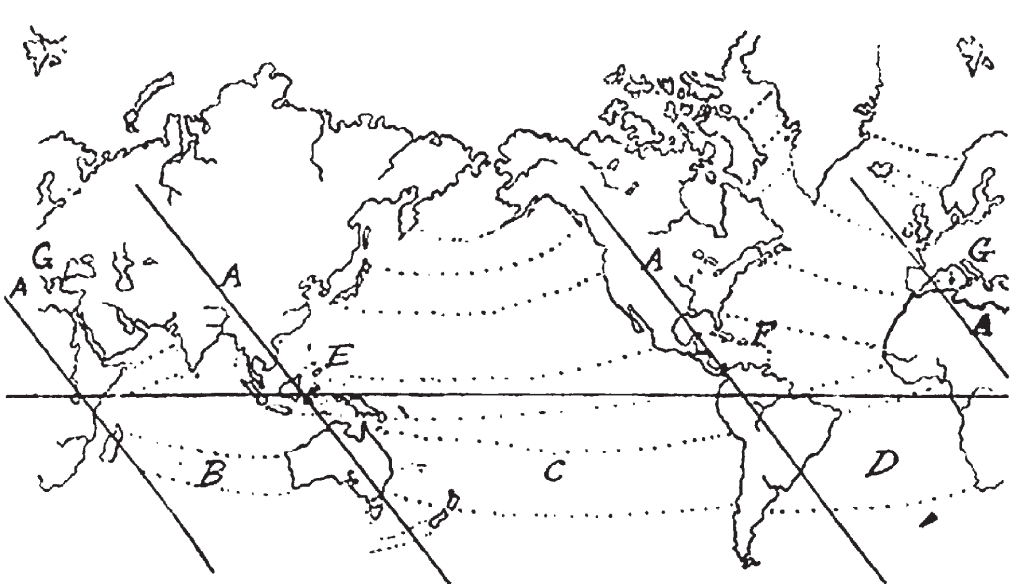
Fig. 7. The global map drawn by Mantovani to describe the Earth’s expansion concept in the work published on the magazine Je m’instruis in 1909. Dotted lines are traced between pairs of points located on opposite oceanic coasts, to indicate that they were once, in the geologic past, coincident, and that the interposed ocean was closed. The dotted lines was traced also across the Pacific and then all the oceans was closed and as final consequence the Earth must has had, in the past, a smaller size than the present